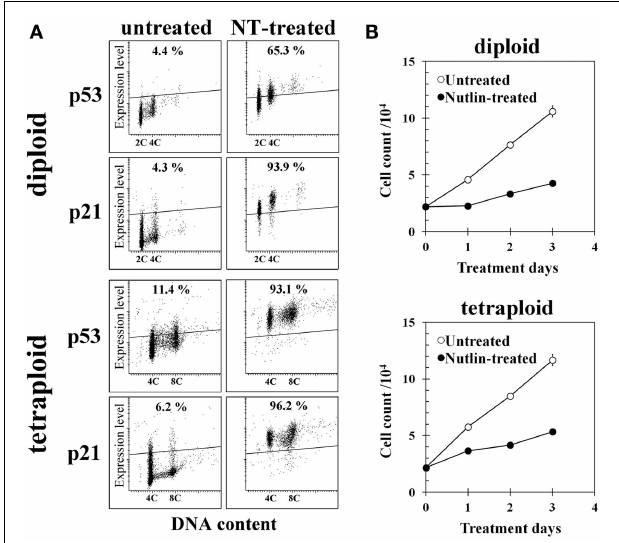
FIGURE 4 | Effect of Nutlin-3a (NT) on gene expression and cell growth of diploid and tetraploid BJ cells. (A) p53 and p21 expression in untreated and NT-treated cells. Cells on glass slides were treated with 10 µ M NT for 24h and immunohistochemically stained with anti-p53 or anti-p21 monoclonal antibody, then analyzed by a laser scanning cytometer as described in the Section “Materials and Methods.”The regions indicating positive expression were drawn above the fluorescence intensity of cells incubated with isotype control antibody. Percentages in the figures indicate frequencies of cells with positive expression of each gene. 2C and 4C indicate the positions of cells with 2C and 4C DNA content. (B) Cell growth of control and NT-treated diploid BJ cells (upper panel) and tetraploid BJ cells (lower panel). Cells were treated with 10 µ M NT continuously.